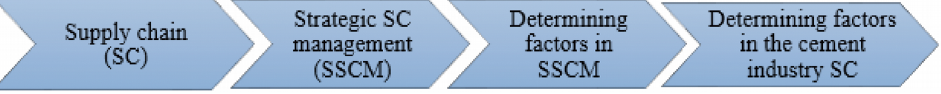
Figure 1. Research